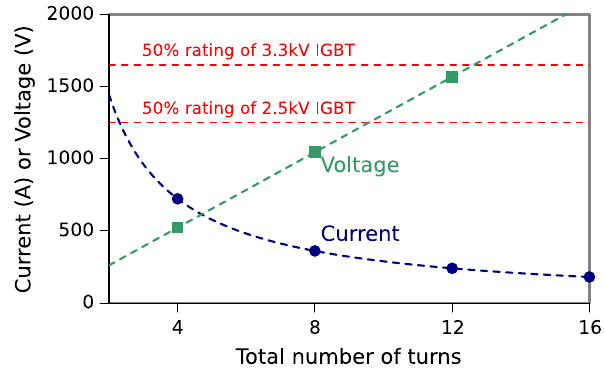
FIG. 4. Plot of the required magnet current and estimated mag- net voltage to achieve a magnetic field integral of 0 . 0545 T · m, as a function of the total number of turns of the magnet coils with a 1.5 m long yoke. End effects are neglected and h ð eff Þ 120 mm × 100 mm is